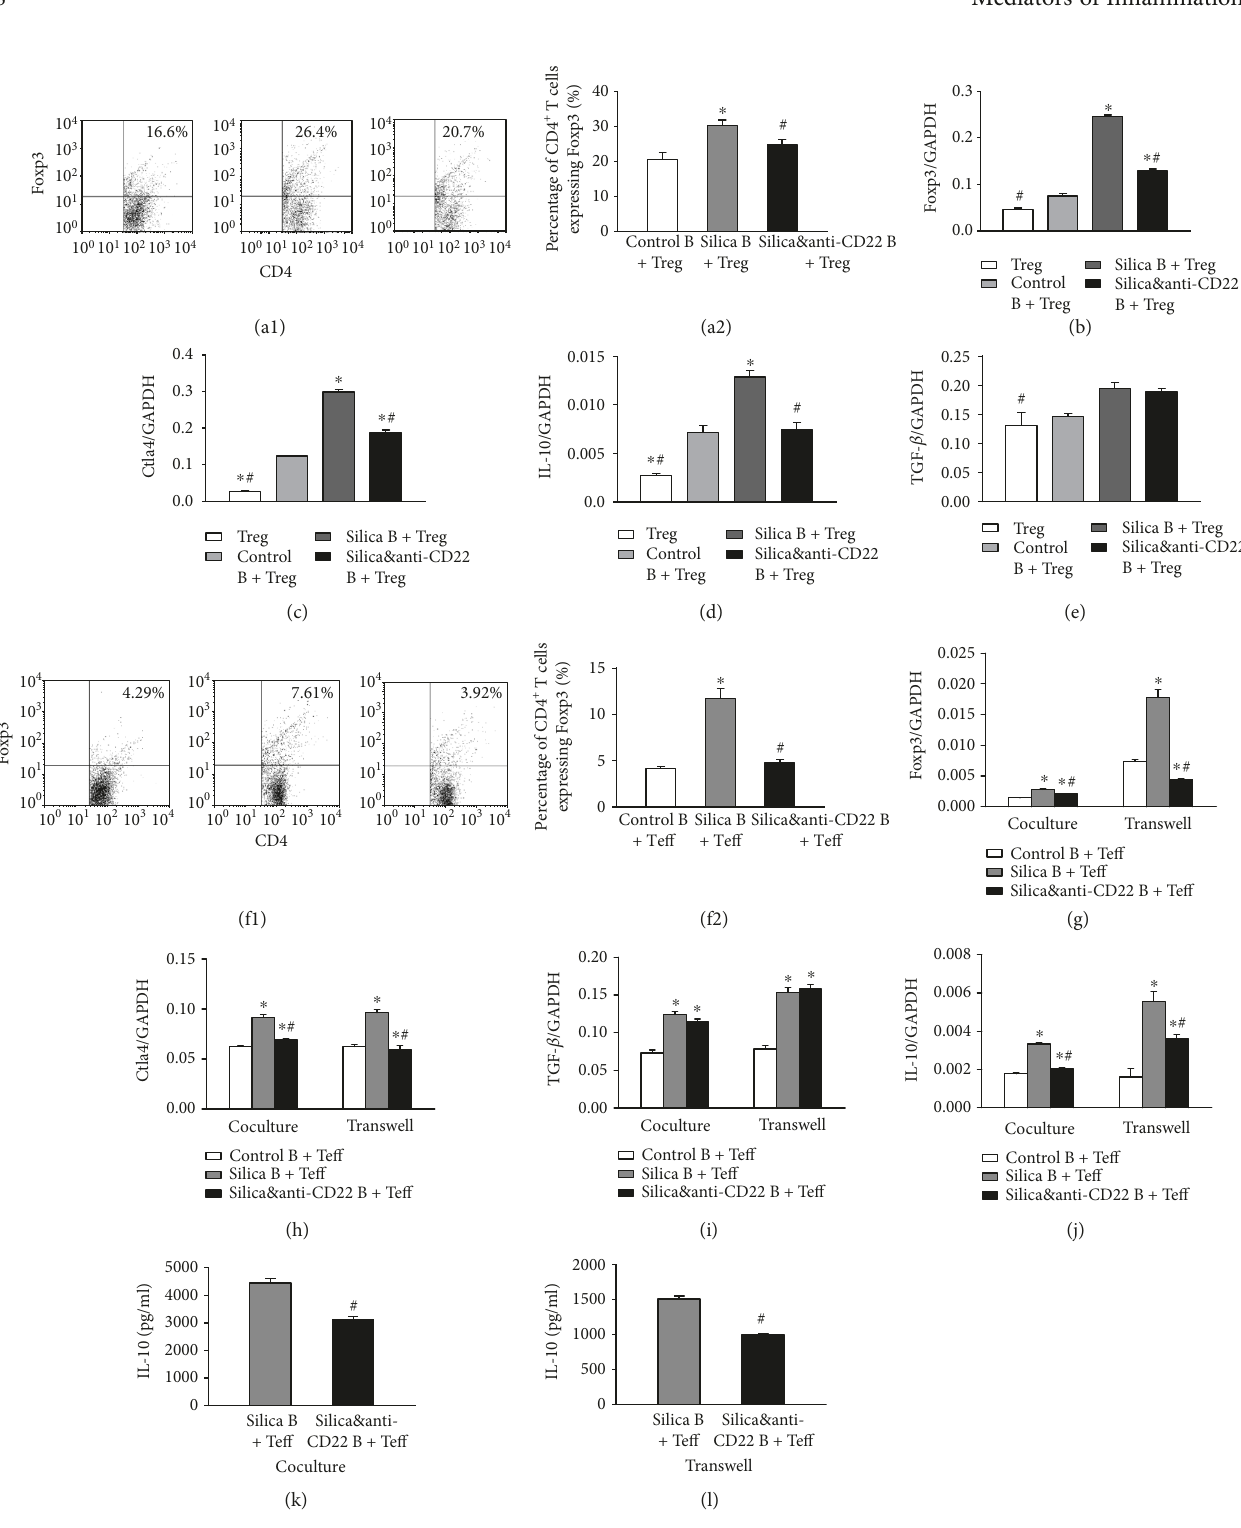
Figure 4: Insu ffi cient B10 both suppressed Treg and inhibited the conversion of Te ff into Treg. (a1, a2) The percentages of CD4 + CD25 + Treg in di ff erent groups of the B cell and Treg coculture system were studied by fl ow cytometry. (b – e) The expressions of Foxp3, CTLA4, IL-10, and TGF- β in di ff erent groups of the B cell and Treg coculture system were assayed by real-time PCR. (f1, f2) The percentages of CD4 + CD25 + Treg in di ff erent groups of the B cell and Te ff coculture system were studied by fl ow cytometry. (g – j) The expressions of Foxp3, CTLA4, IL-10, and TGF- β in di ff erent groups of the B cell and Te ff coculture system with or without insert plates were assayed by real-time PCR. (k, l) The secretions of IL-10 in supernatant of the B cell and Te ff coculture system were assayed by CBA. (Data was presented as mean ± SEM ( n =5). ∗ p < 0 05 , signi fi cantly di ff erent compared with the control B+Te ff group. # p < 0 05 , signi fi cantly di ff erent compared with the silica B+Te ff